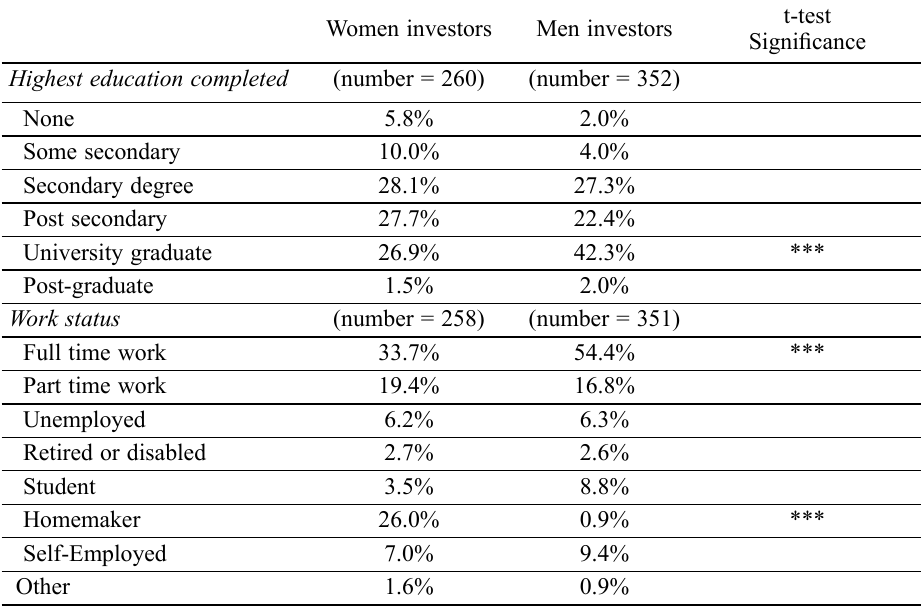
Table 3. Gender differences in social factors